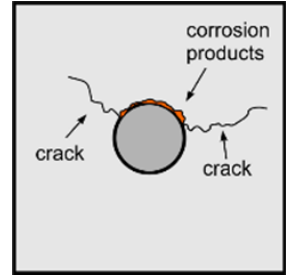
Figure 1. Partial circumferential debonding caused by corrosion damage in reinforced concrete beam.